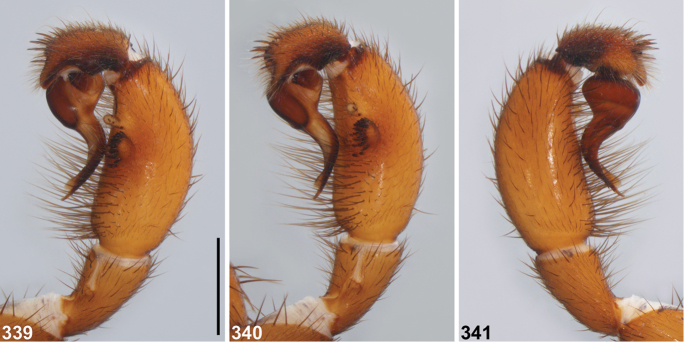

Idiosoma
schoknechtorum sp. n., male holotype (WAM T139512) from Beverley (Western Australia; AVW), pedipalp. 339 Retrolateral view 340 Retroventral view 341 Prolateral view. Scale bar 2.0.